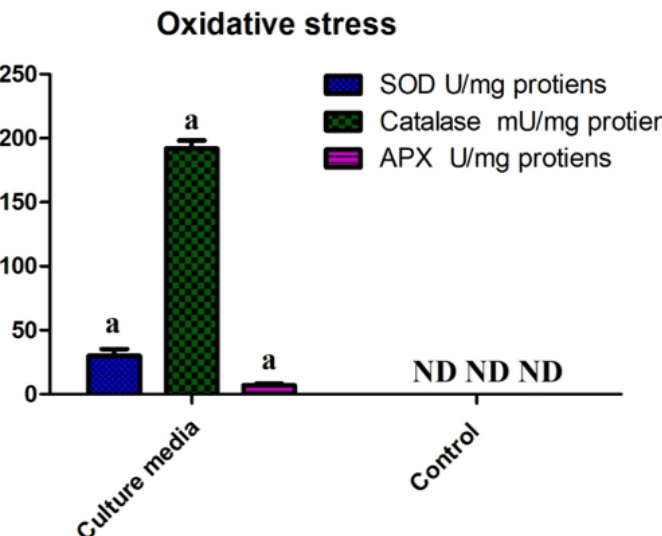
Figure 5. Oxidative stress tolerance activities of SH-6. Each data point is the mean of 5 replicates. The error bar represents the standard error among the replicates. The latter on each bar is the significant different between treatment at p ≤ 0.5, where ND = not detected.